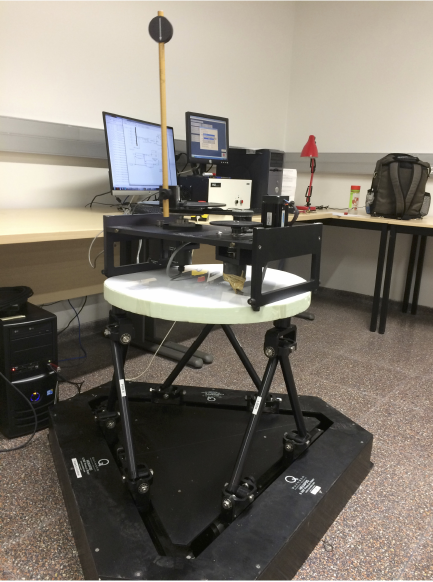
Figure 1. Experimental setup: Furuta pendulum located on a Steward